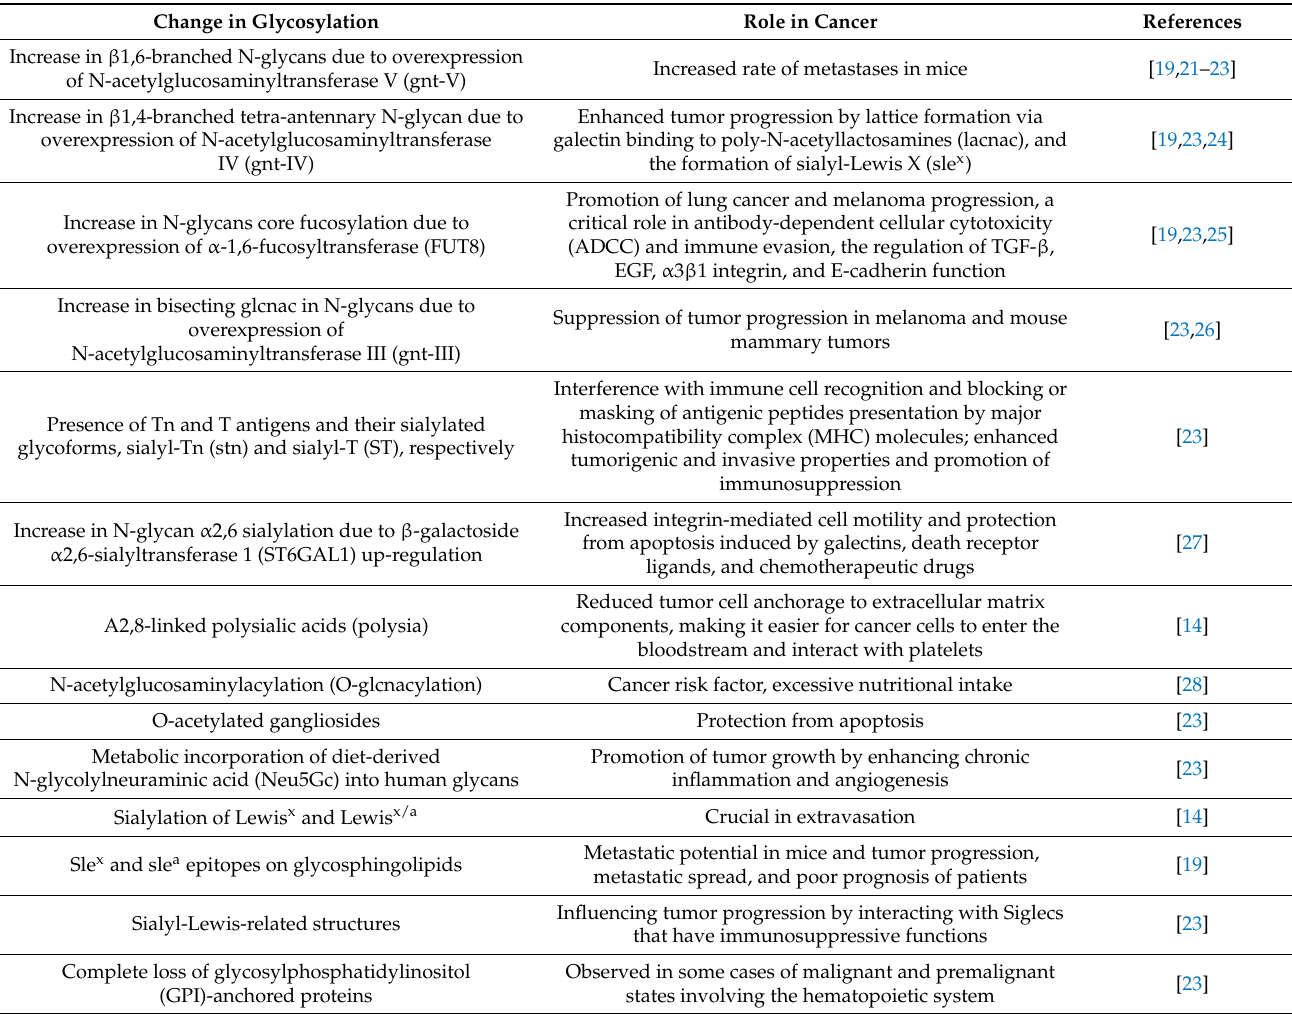
Table 1. Changes in glycosylation of cancer cells and their impact on cancer